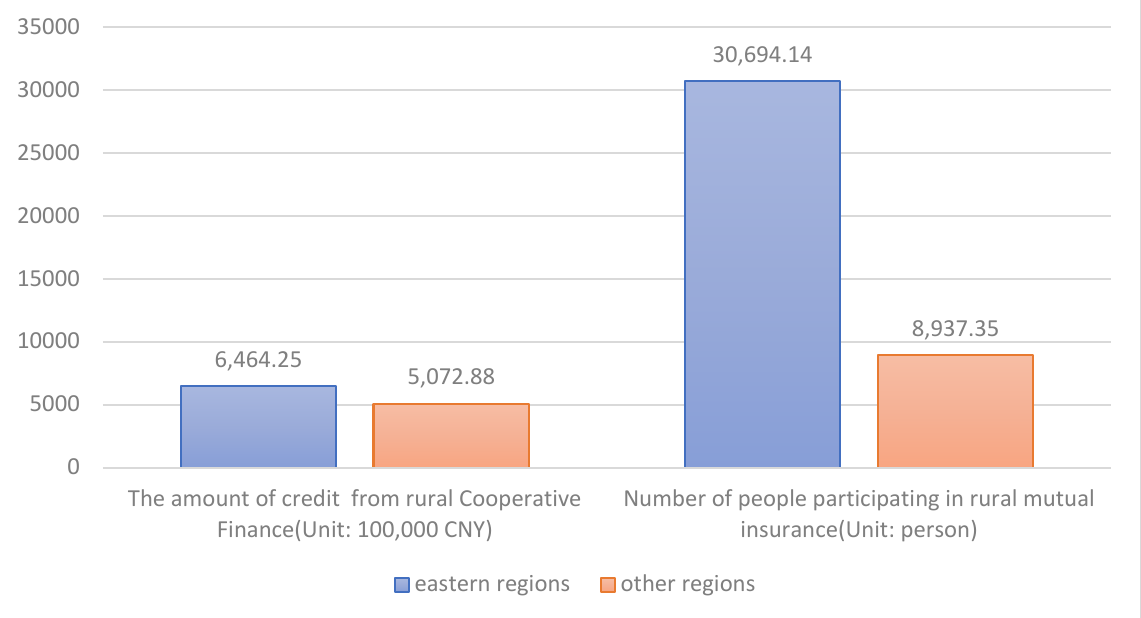
Figure 5. Average usage level of rural mutual insurance and rural cooperative finance in 2018 (Data source: Ministry of Agriculture and Rural Affairs of China. China Agricultural Management Statistical Annual Report (2018). Beijing, P. R. China http://zdscxx.moa.gov.cn:8080/nyb/pc/messageList.jsp (accessed on 10 October 2020)).